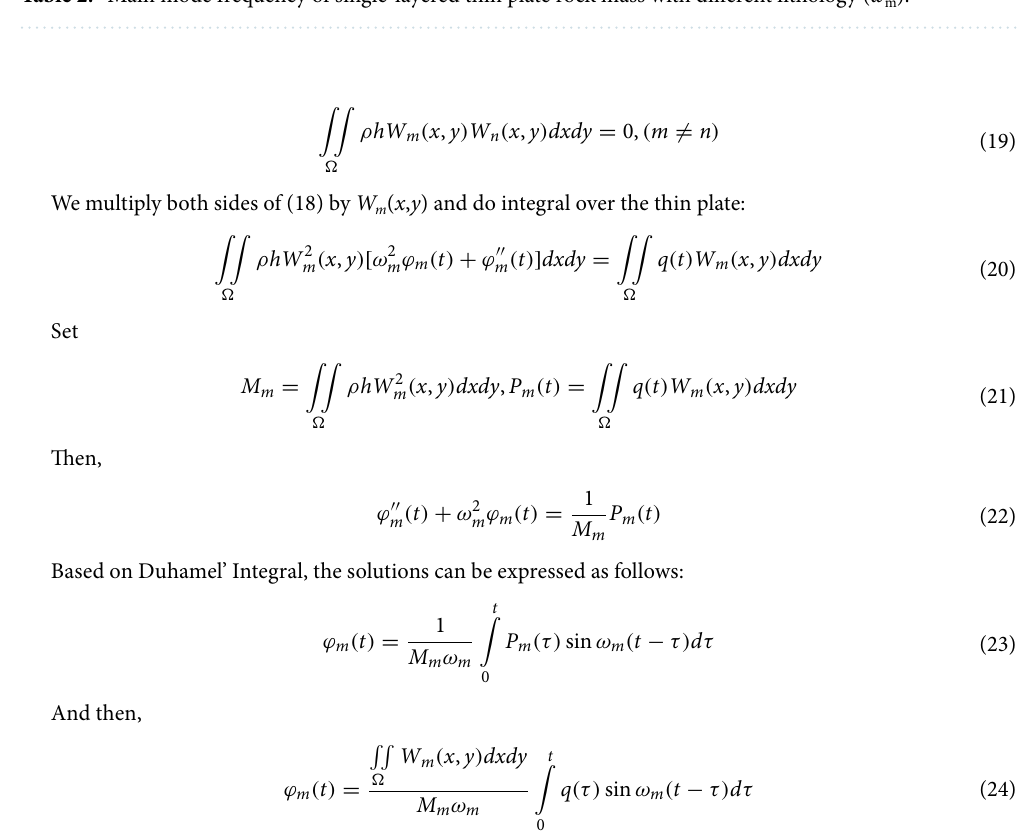
Table 2. Main mode frequency of single-layered thin plate rock mass with different lithology ( ω m